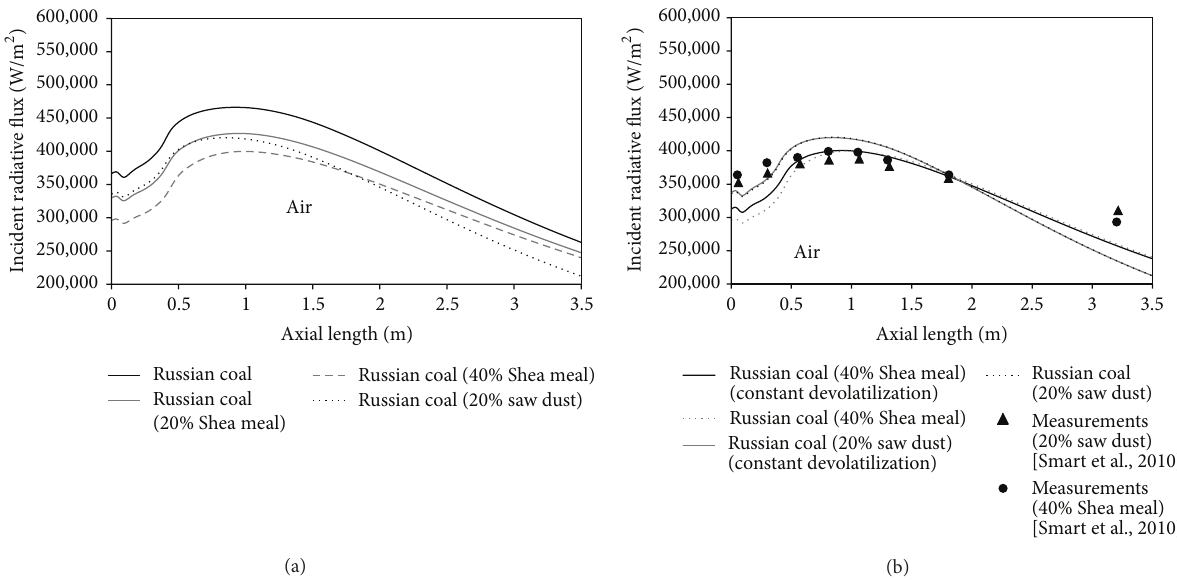
Figure 9: Wall incident radiative flux profiles predicted during the co-combustion of Russian coal and biomass particles in air.